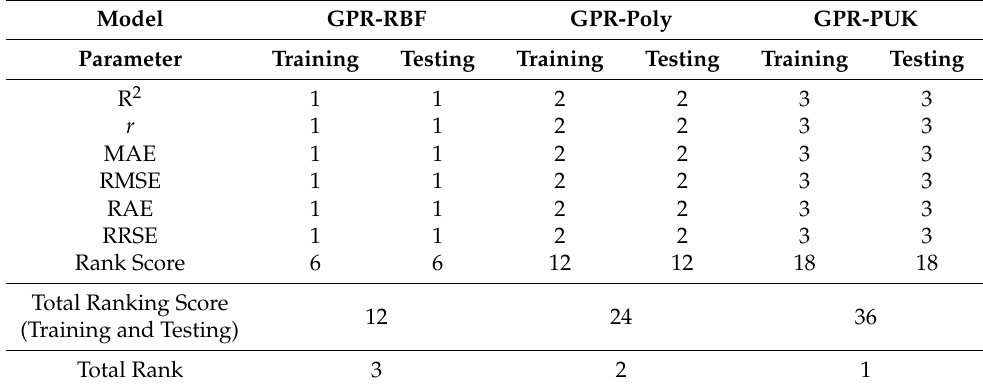
Table 6. The results of the employed models’ rank